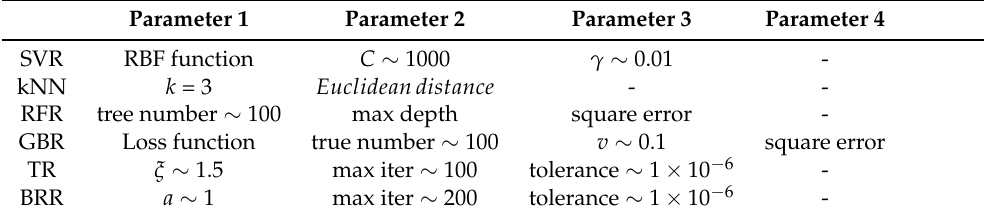
Table 2. Machine learning parameters for the